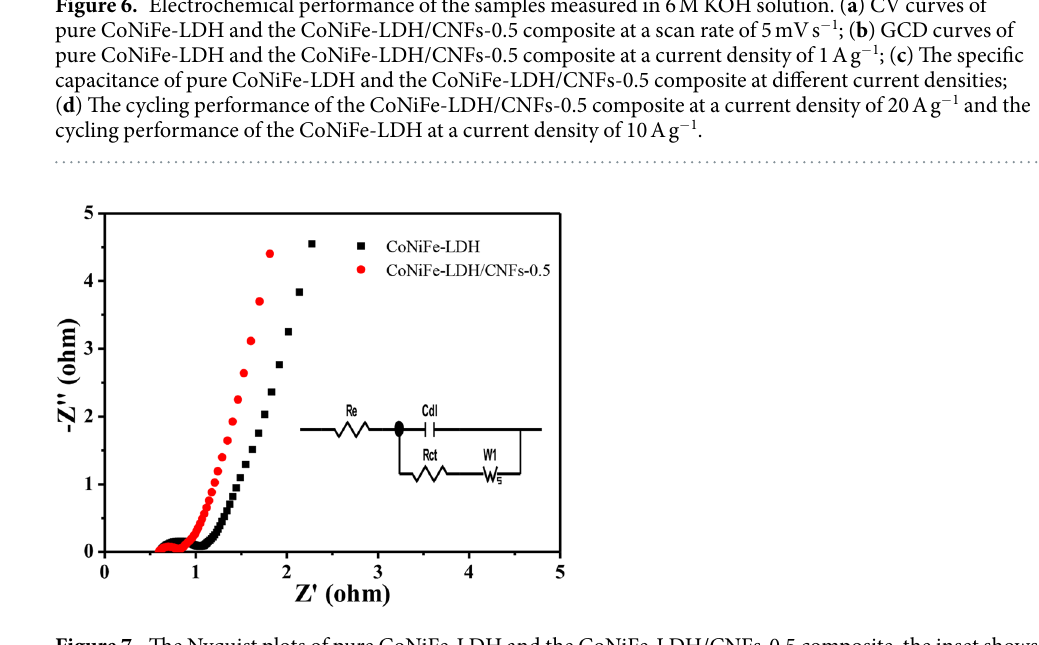
Figure 7. The Nyquist plots of pure CoNiFe-LDH and the CoNiFe-LDH/CNFs-0.5 composite, the inset shows the equivalent circuit